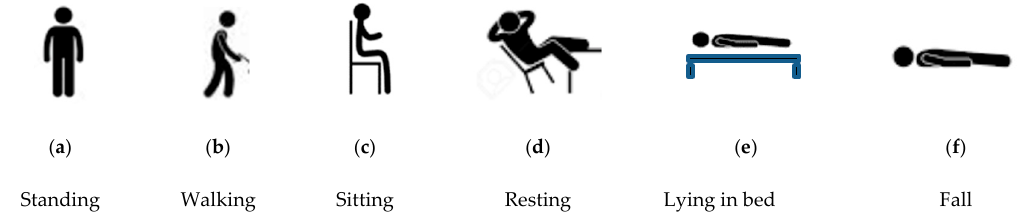
Figure 2. Six basic activities of daily living patient positions to reflect daily activity